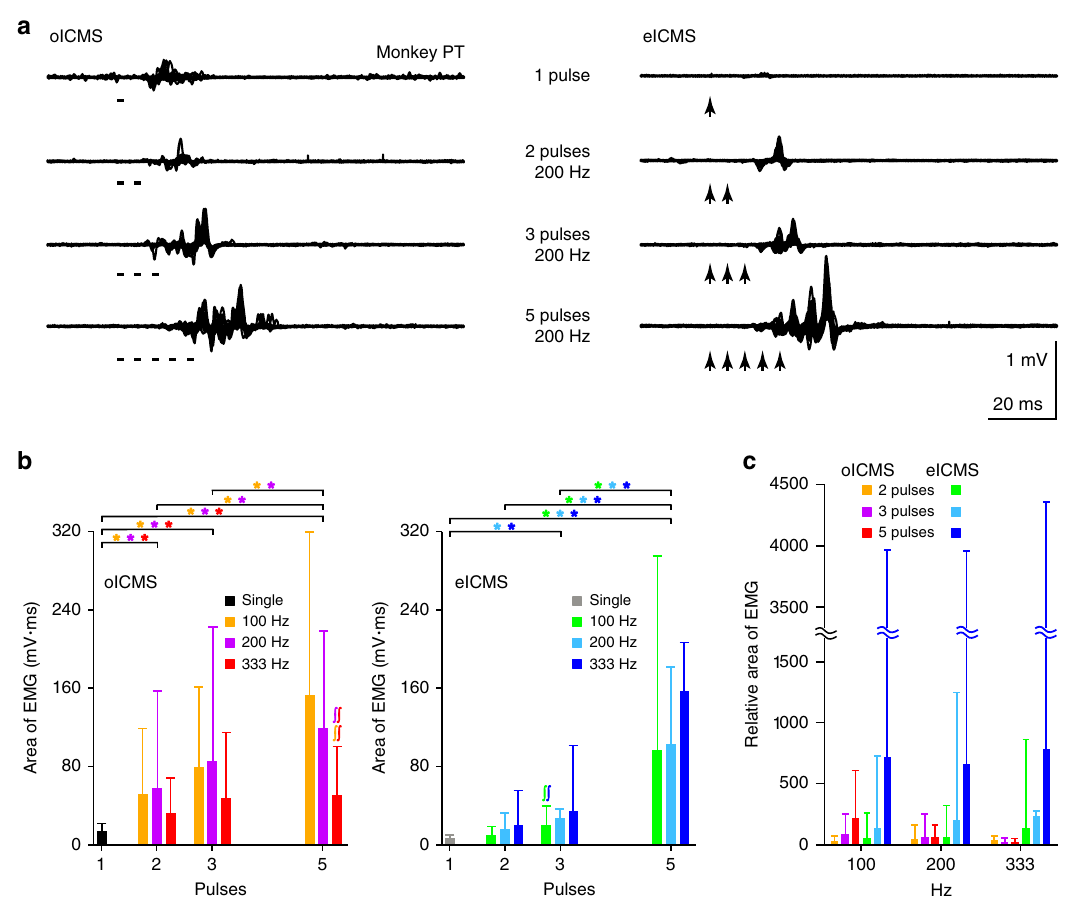
Fig. 4 Muscle activity evoked by oICMS and electrical ICMS (eICMS). a Raw EMG recorded from the fl exor carpi radialis muscle. One, two, three, and fi ve stimulus pulses of oICMS (left, 15 mW strength corresponding to 1910 mW/mm 2 , 2 ms pulse duration, 200 Hz) and eICMS (right, 50 µ A strength, 0.2 ms pulse duration, 200 Hz) were applied to the same site. b The area of EMG evoked by oICMS (left, 15 mW corresponding to 1910 mW/mm 2 , 2 ms) and eICMS (right, 40 – 65 µ A, 0.2 ms) with one, two, three, and fi ve pulses at different frequencies. The EMG data were averaged across stimulating sites (33 and 19 sites for oICMS and 19 and 20 sites for eICMS in Monkeys HJ and PT, respectively). Bar graphs represent means and SDs. Different colors indicate different frequencies (single-pulse, 100, 200, and 333 Hz). * p < 0.05, signi fi cantly different between stimulus pulses in the frequency indicated by the color; ∫ p < 0.05, signi fi cantly different from each other between stimulus frequency indicated by the color (Friedman test with Dunn ’ s post hoc test). c The relative area of EMG evoked by repetitive oICMS (warm colors) and eICMS (cold colors) with two, three, and fi ve pulses (indicated by different colors) at different frequencies (100, 200, and 333 Hz). The same datasets as in b were used, and the area of EMG was normalized to that evoked by single-pulse oICMS/eICMS. Bar graphs represent means and